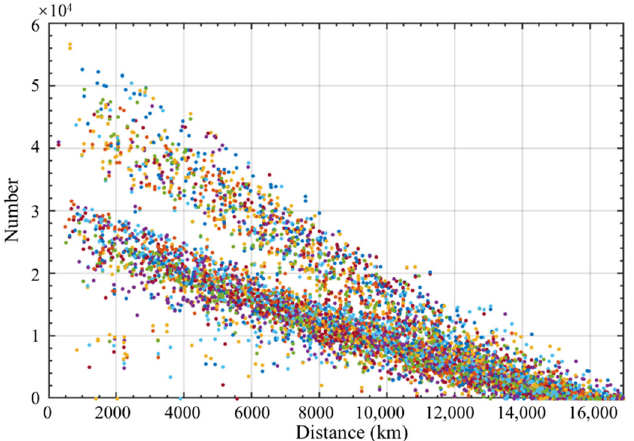
Figure 6. Variation of the number of DD observations between every two stations with distance. This